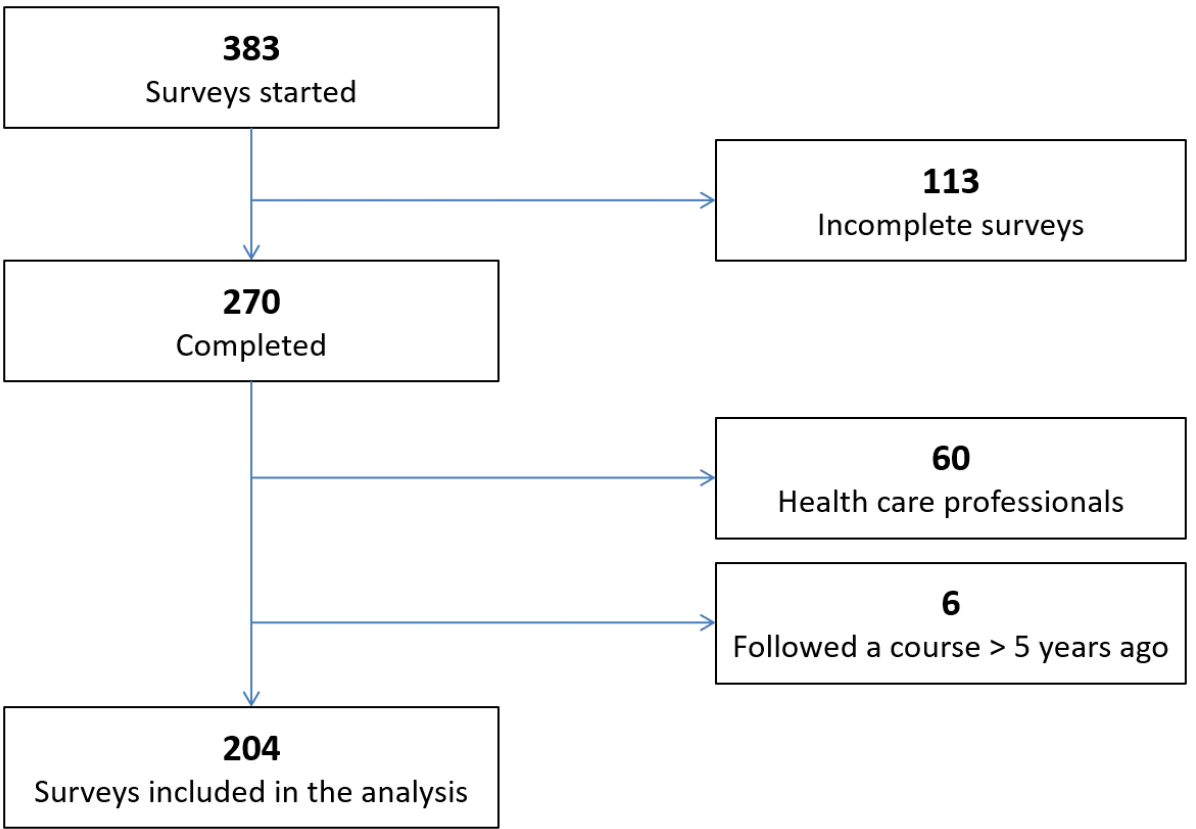
Figure 1. Flowchart of the inclusion of former first-aid course participants (Geneva, Switzerland,